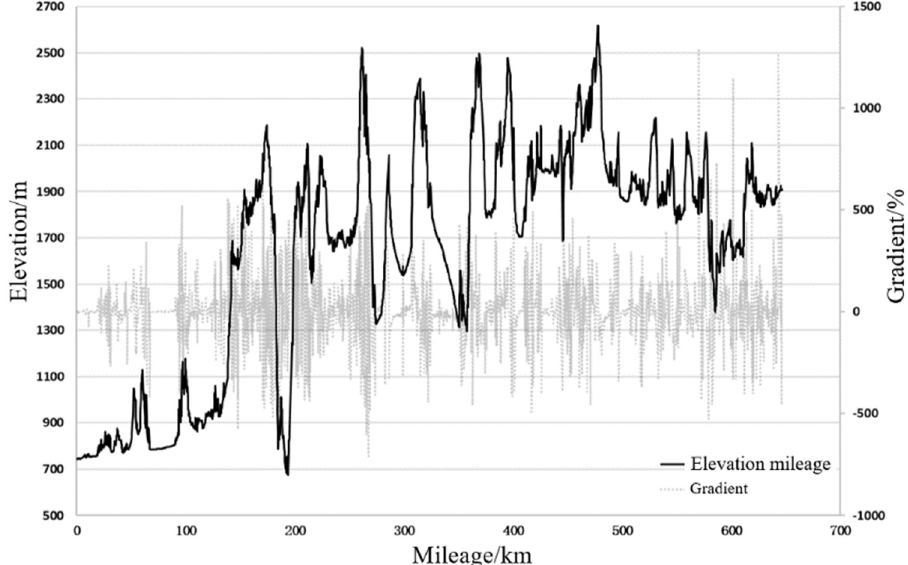
Figure 5. Elevation mileage and gradient map of a crude oil pipeline in China.